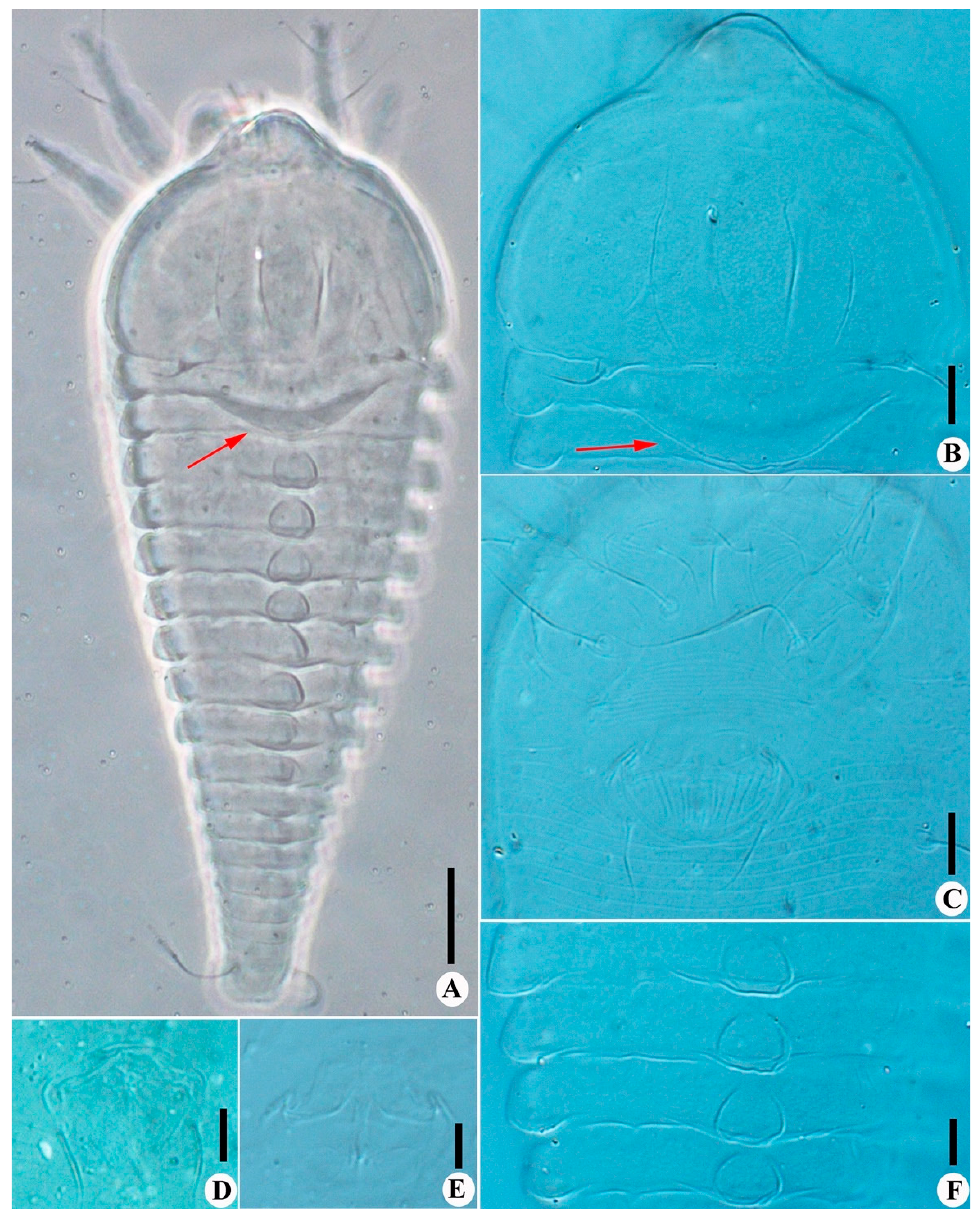
Figure 6. Neotegonotus ulmchangus sp. nov. ( A ) dorsal view; ( B ) prodorsal shield; ( C ) female coxigenital area; ( D ) male genitalia; ( E ) female internal genitalia; ( F ) dorsal annuli. Scale bar: 20 μ m for A; 10 μ m for B, C, F; 5 μ m for D, E. Arrows indicate the first dorsal annuli broad, projecting the posterior.